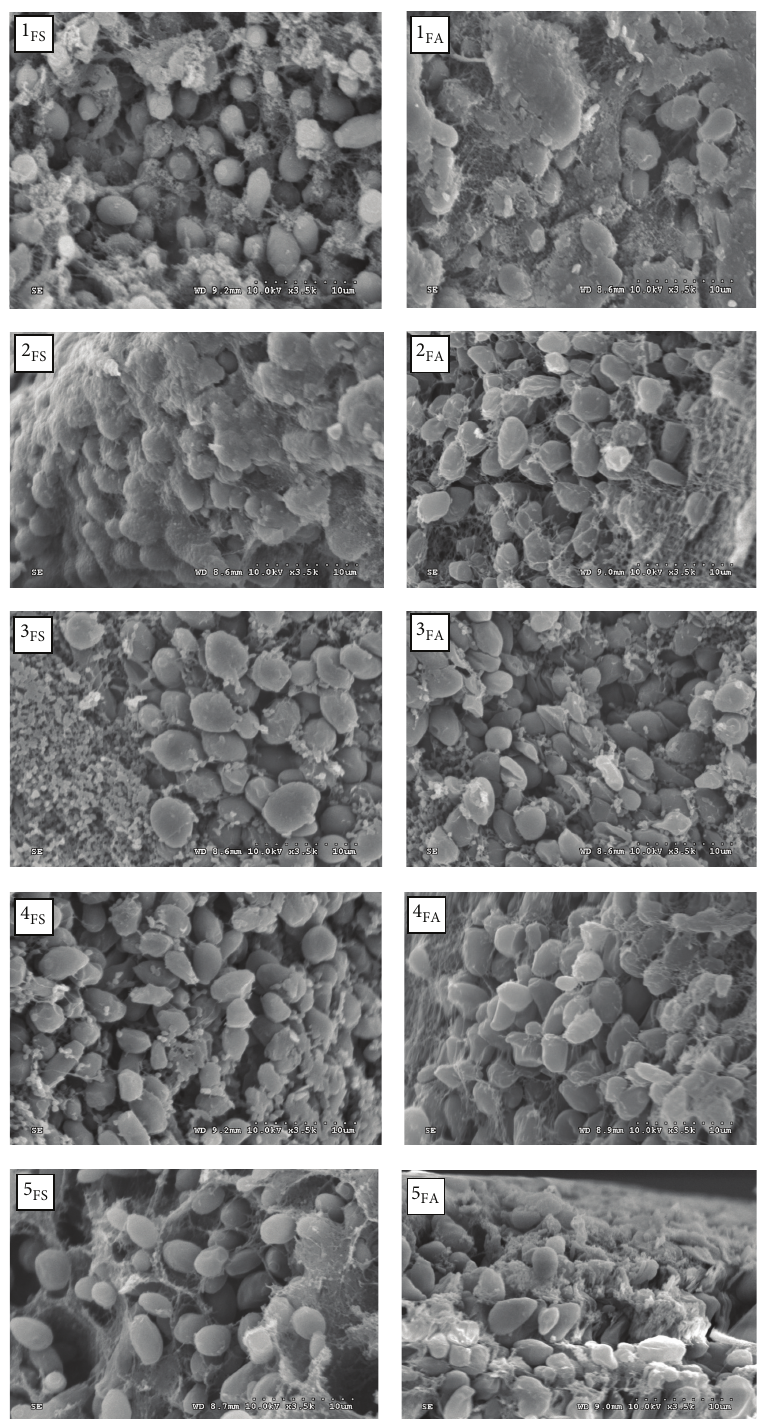
Figure 4: The morphology of immobilized cell bead after five batch fermentation rounds (FS: fermentation of hydrolysate detoxified by SAA pretreatment; FA: fermentation of hydrolysate detoxified by two-step adsorption method. The digit number of 1, 2, 3, 4, and 5 means batch fermentation